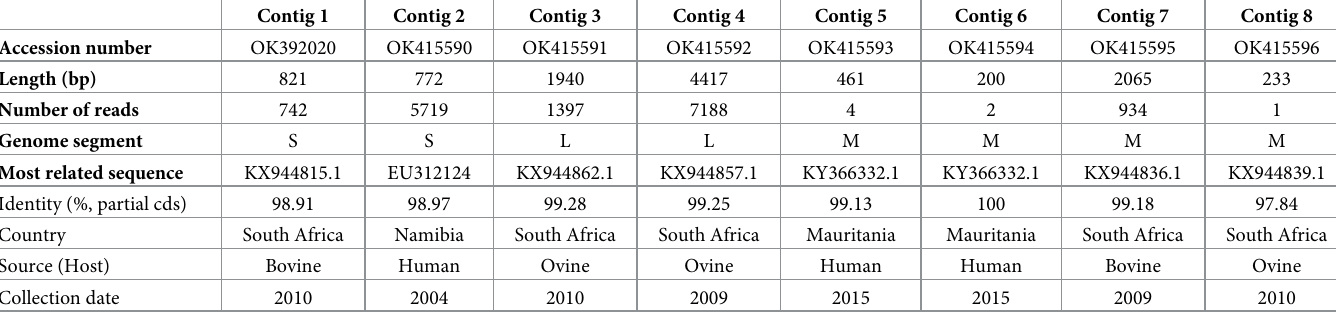
detectable IgM antibodies against RVFV. In sera of local cattle sampled one month earlier on the same farm, IgM antibodies against RVFV were detected in three out of 28 (10.7%) animals ( Fig 4 ). No evidence of RVFV-derived RNA was detected in any of the 44 tested sera and the examination of IgM positive sera revealed no evidence of replicable RVFV. III.II.II. Flavivirus and Orthobunyavirus detection. No evidence of Flavivirus -specific or Orthobunyavirus -specific RNA was found in any of the 44 serum samples. Table 5. Summary of HTS and alignment results of the RVFV-positive mosquito